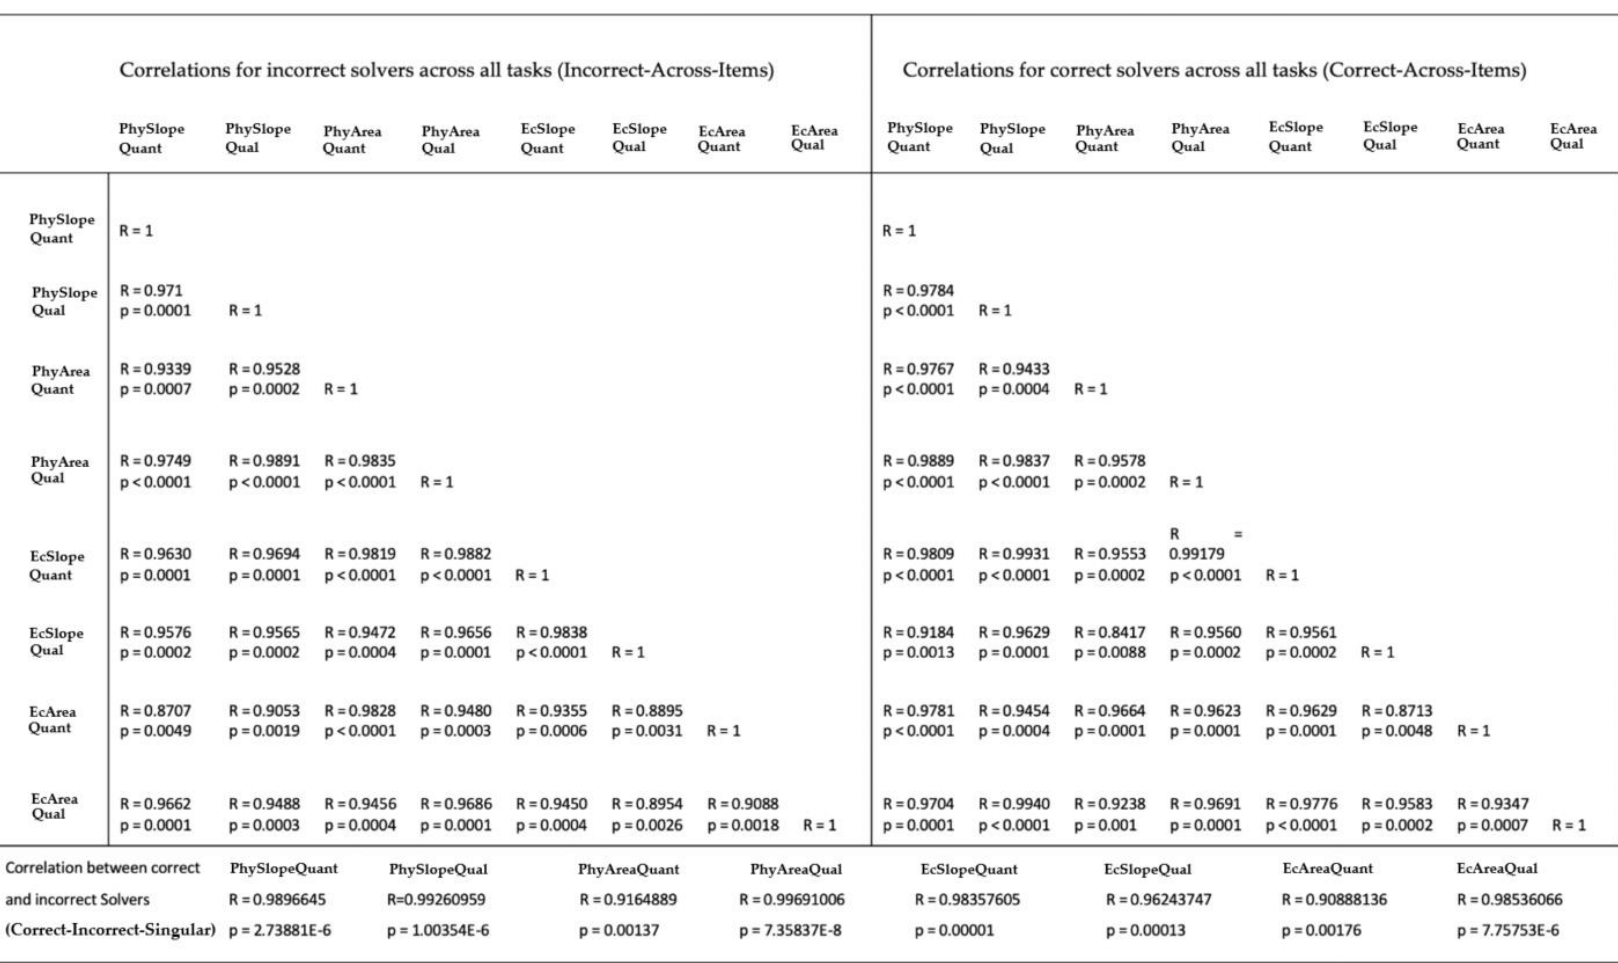
Figure 3. Correlations for % of AOI fixation. Top Left: Correlations for incorrect solvers across all tasks (Incorrect-Across-Items). Top Right: Correlations for correct solvers across all tasks (Correct-Across-Items). Bottom: Correlations between correct and incorrect solvers for each individual task (Correct-Incorrect- Singular).